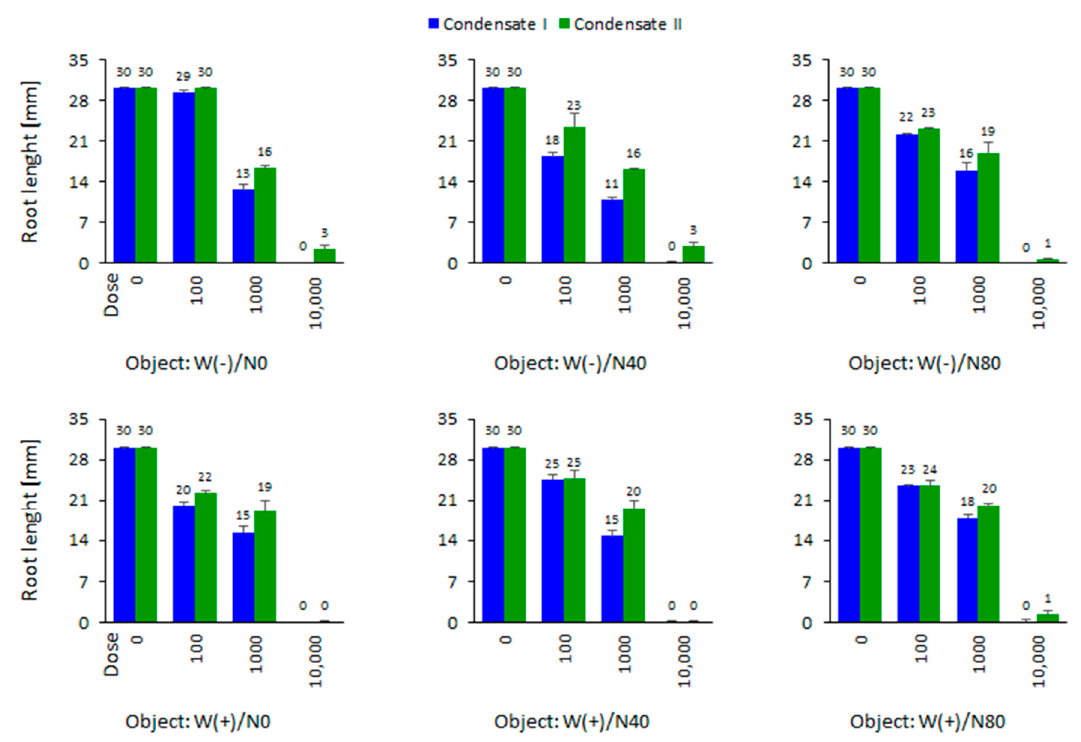
Figure 11. E ff ect of tar on Sinapis alba root elongation in ecotoxicity Figure 11. Effect of tar on Sinapis alba root elongation in ecotoxicity biotests.